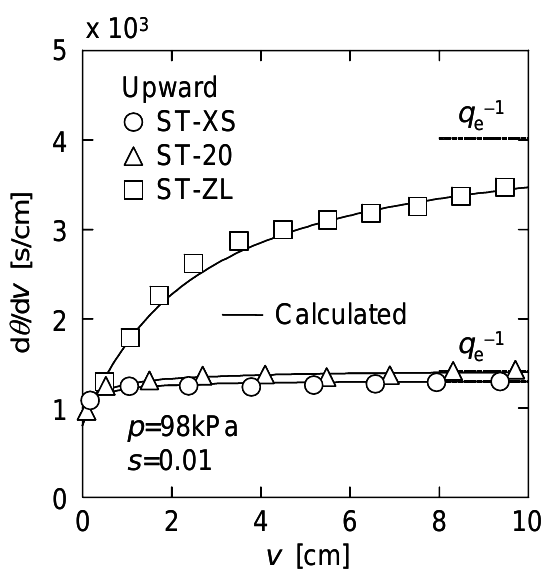
Figure 4. Reciprocal filtration rate in upward